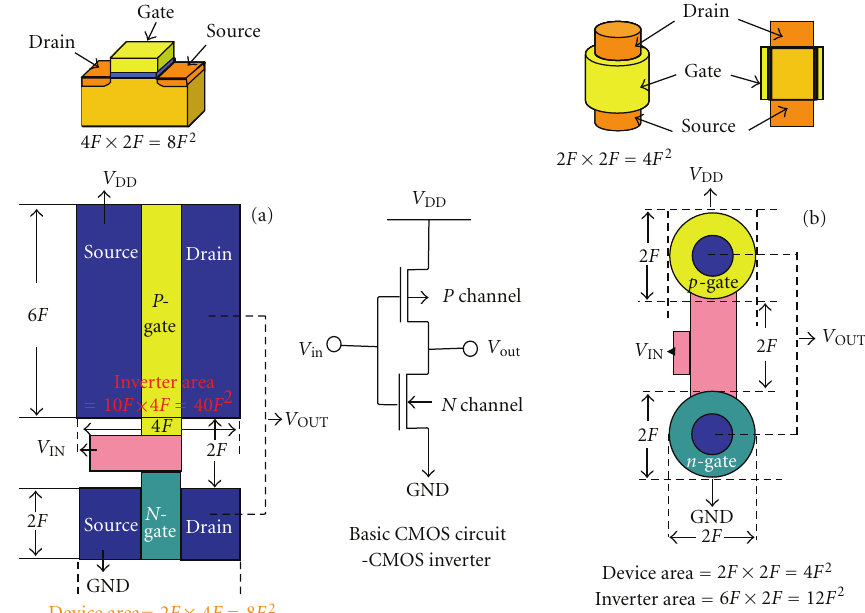
Figure 1: Schematic illustration of the footprint of (a) lateral and (b) vertical GAA nanowire MOSFET and corresponding CMOS